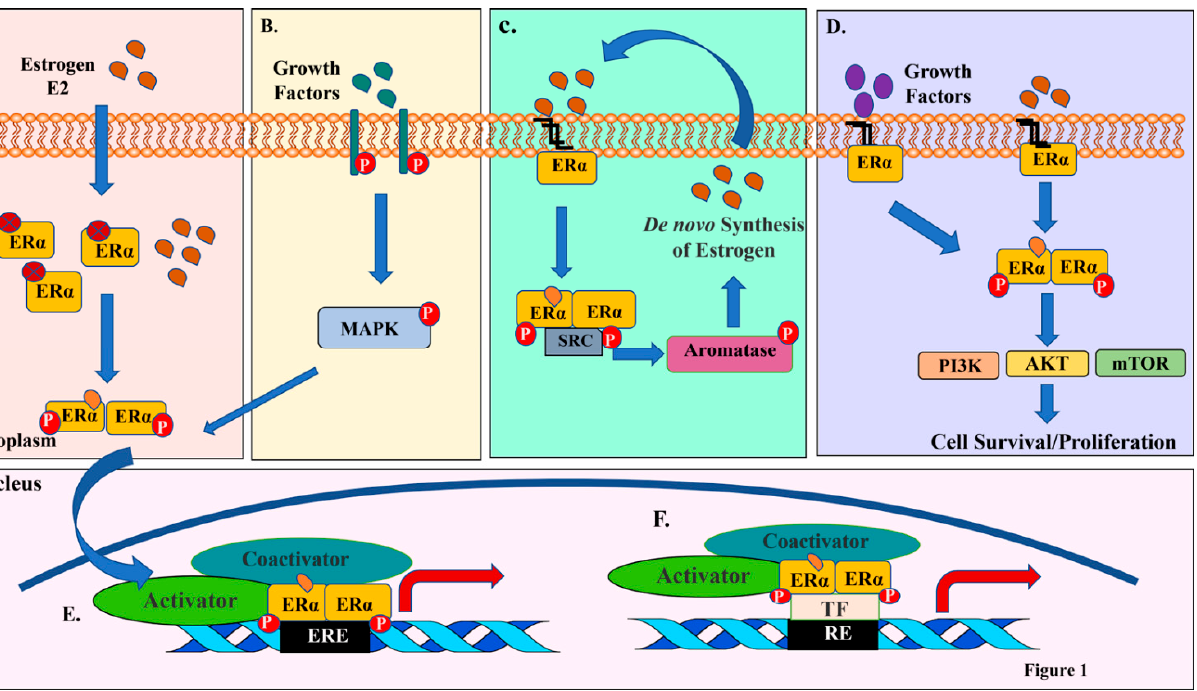
Figure 1. ER α :E2 signaling network and crosstalk with growth factor signaling. ( A ) Schematic view of classic genomic ER α :E2 signaling involving passive diffusion of E2 into cytoplasm and nucleus and activation of ER α signaling. ( B ) Growth factors activate receptor tyrosine kinases, which activate MAPKs. MAPKs can then phosphorylate and activate ER α either independent of E2 or synergize with E2 for optimal ER α activation. ( C ) Membrane associated ER α interacts and activates SRC kinase upon ligand binding. SRC kinase then phosphorylates and activates aromatase, which catalyzes conversion of androgens to estrogens within cells and amplify both genomic and nongenomic ER α -E2 signaling. ( D ) Membrane anchored ER α can also activate various cytoplasmic kinases including PI3K-AKT-mTOR pathway through nongenomic actions and these actions occur rapidly (within five minutes) after encountering the ligand. Activated PI3K-AKT-mTOR can enhance genomic actions of ER α (depicted in Figure 3). ( E , F ) Activated ER α alters gene expression in the nucleus through either direct binding to estrogen response elements (EREs) in the genome or bind genome by tethering onto other transcription factors (TFs) and their response element (RE).